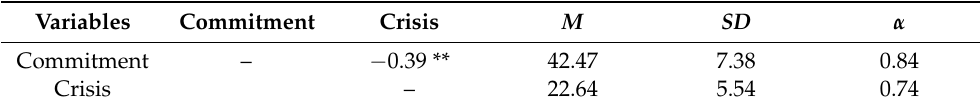
Table 2. Correlation matrix of subscales means, standard deviations, and alpha reliabilities of the Institutional identity Scale for University Students ( N = 707). Variables